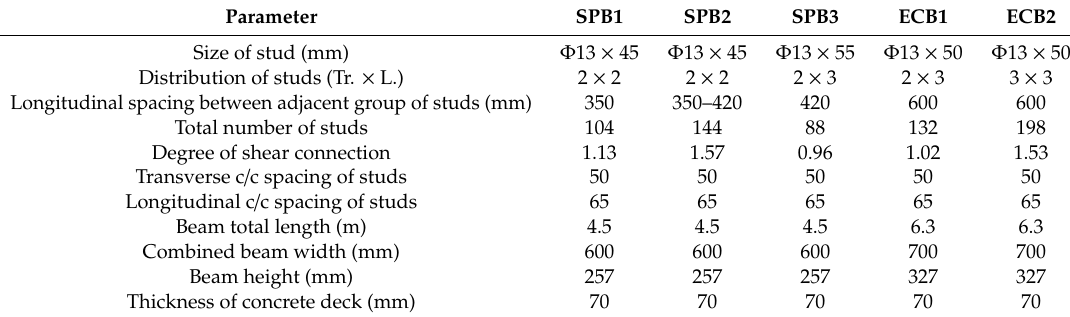
Table 2. The design parameters of SPBs and ECBs.